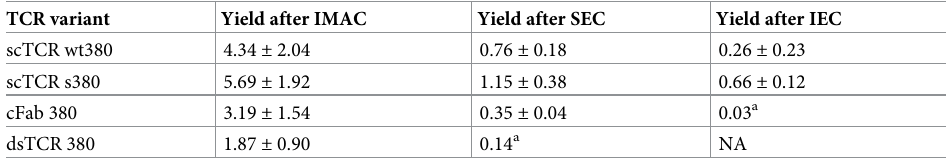
Table 1. Protein yields after each purification